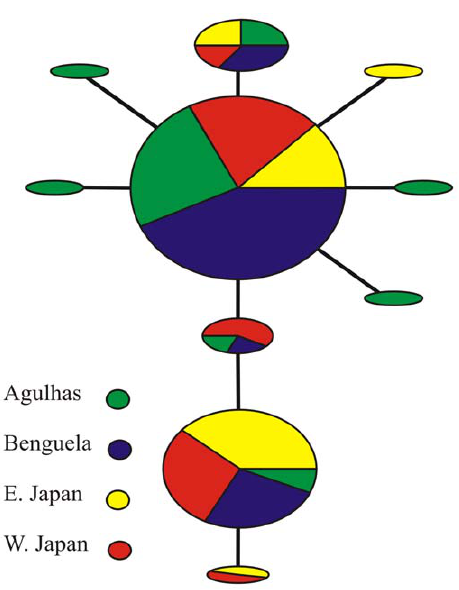
Figure 2. TCS network diagram for mtCOI haplotypes for C. sinicus and C.agulhensis . Numbers of individuals are reflected in the pie size; pie slices represent the frequencies of each haplotype in that population. See text for explanation.